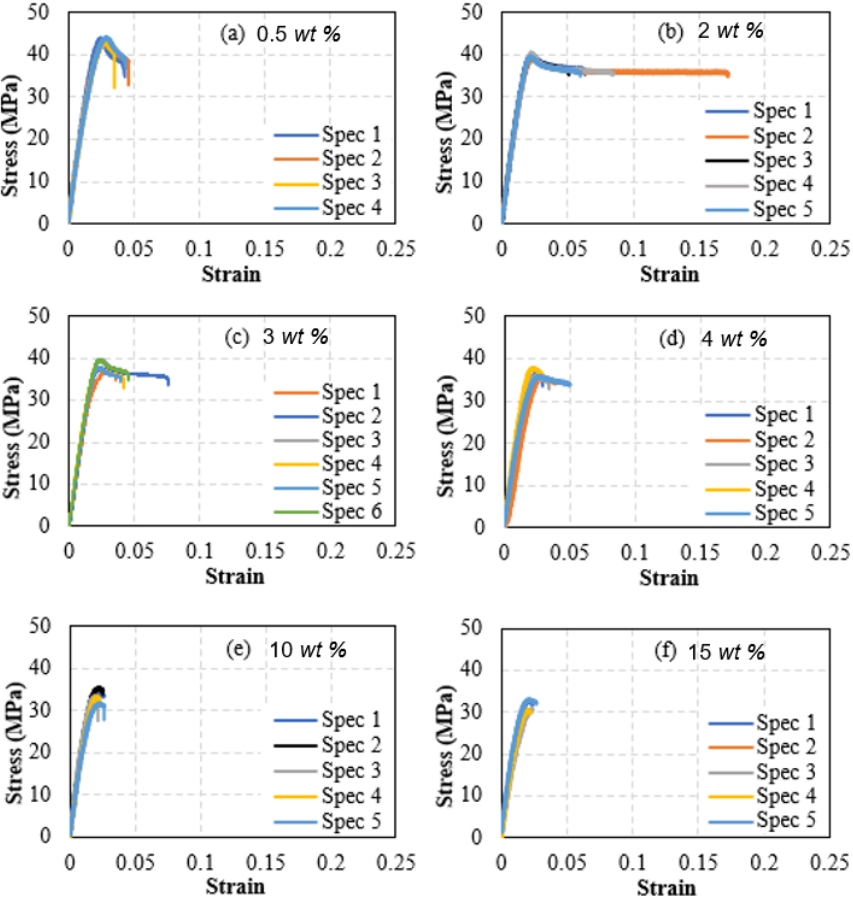
Figure 11. Stress-Strain curves of PLA filaments reinforced with fine dune sand. Subfigures ( a – f ) correspond to the sand weight fractions of 0.5%, 2%, 3% 4%, 10%, and 15%, respectively.